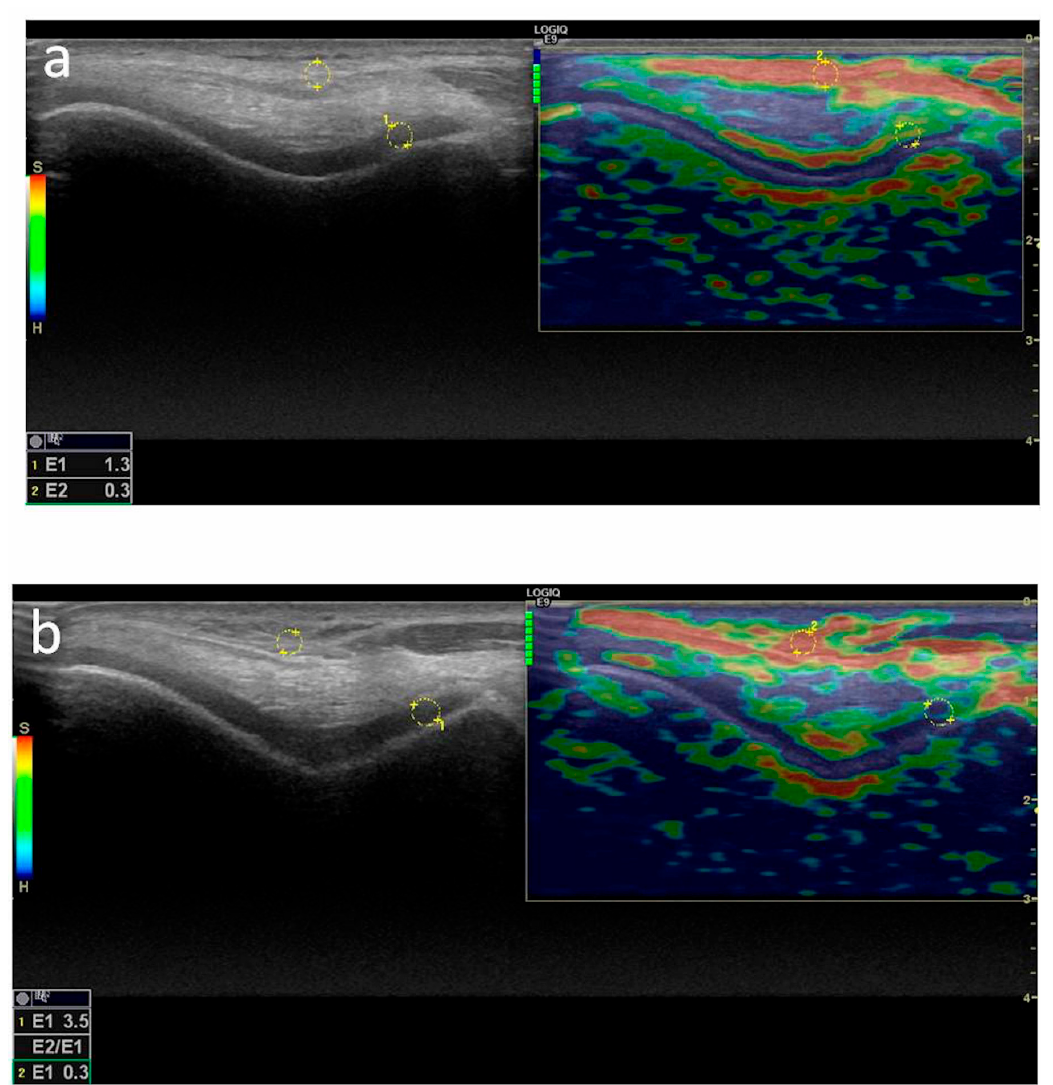
Figure 2. Color-coded real time images of distal femoral cartilage of non-smoking ( a ) and smoking ( b )